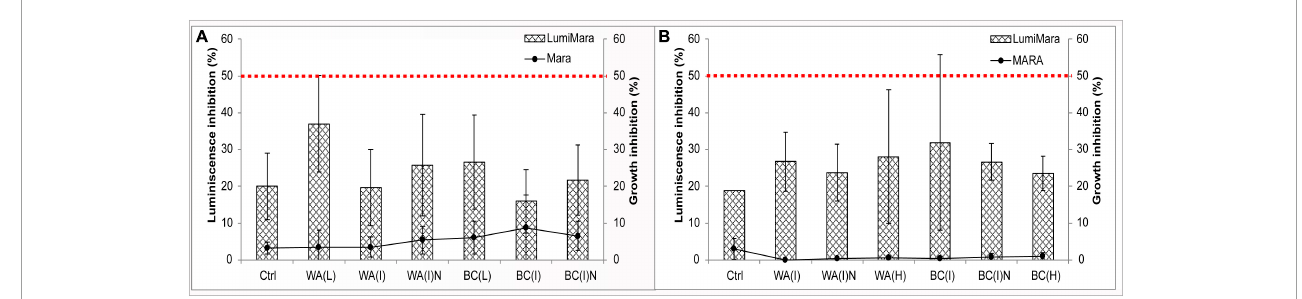
FIGURE4 Effect of the treatments (Ctrl, control; BC, biochar; WA, wood ash; (H), high dose; (I), intermediate dose; (L), low dose; N = 0.8% of N ) on bioluminescence inhibition (left y axis) measured with LumiMARA (bars) and pellet mean growth inhibition represented by dots (right y axis) determined by the MARA bioassay. Treatment effect was analyzed for both experimental sites: ES-K (A) on the left side, and ES-O (B) soil on the right side. Red flashing line (dotted red line) represents the 50% of growth and luminescence inhibition threshold for being